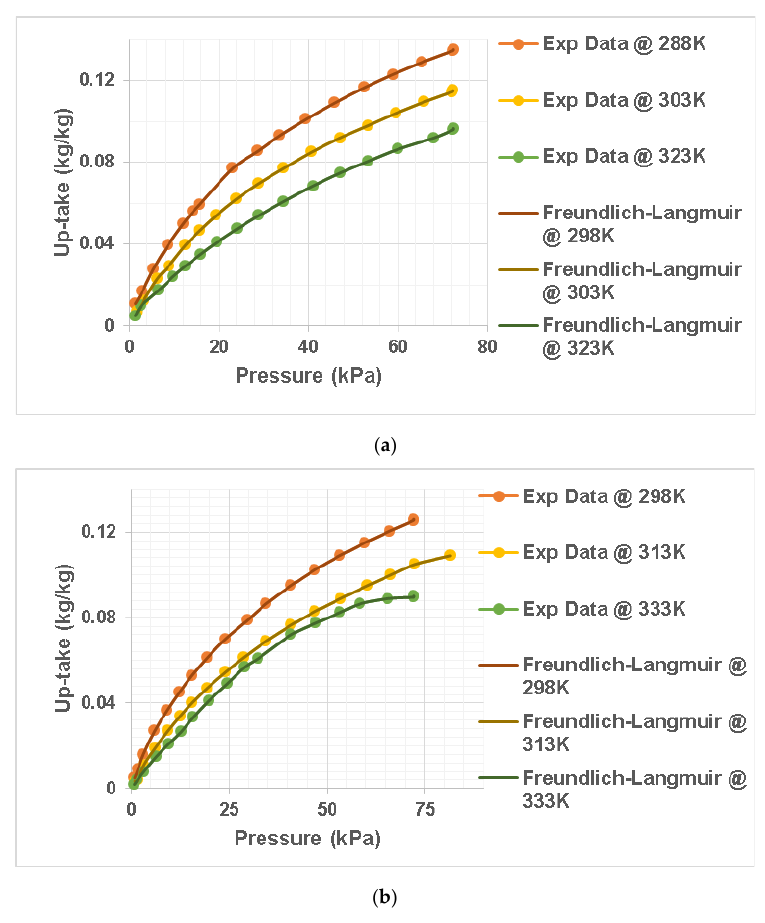
Figure 1. The Freundlich – Langmuir fit for vapour adsorbed at six different temperatures (283 K – 333 K). ( a ) represent vapour uptake of 283 K, 303 K and 323K. ( b ) represent vapour uptake of 293 K, 313 K and 333 K.